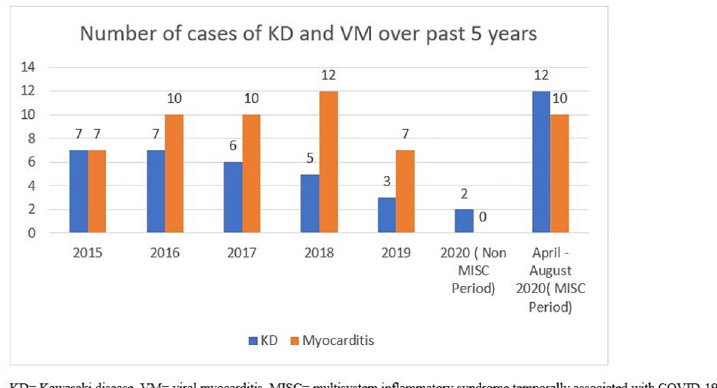
Fig 2. Number of cases with Kawasaki Disease (KD) and Viral Myocarditis (VM) over past 5